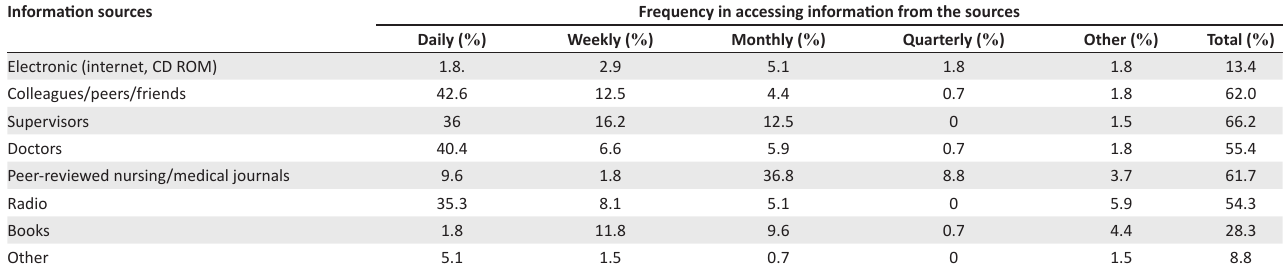
TABLE 2: Participants’ current sources of information and the frequency with which they access the sources ( n = 136). Information